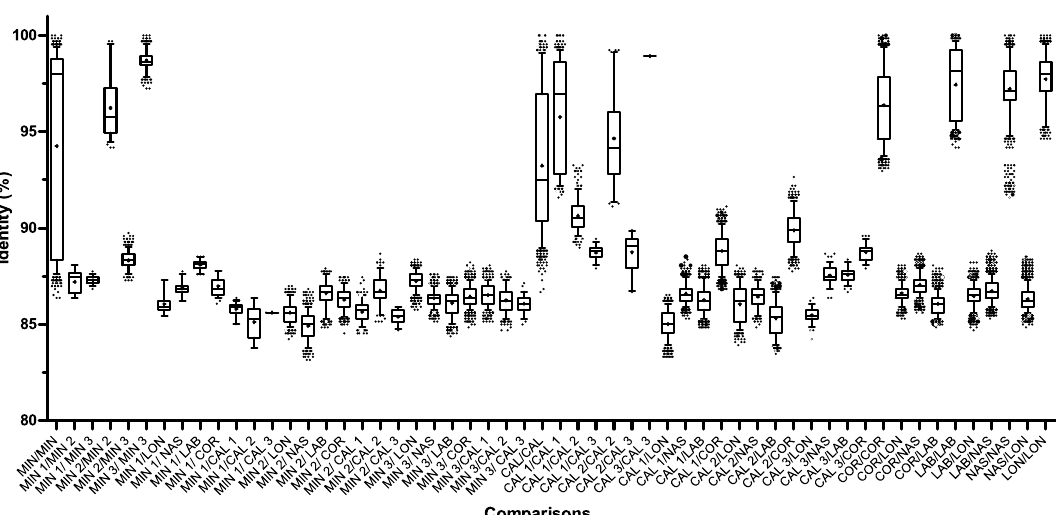
Figure 5. Comparison of sequence identity between different species and operational taxonomical units (OTU) on the cytochrome oxidase I sequences. Identities were calculated using dist.dna function and plotted as boxplots (medians and 25%/75% percentiles) with whiskers showing the 95% percentiles and outliers shown by dots. Means are shown as crosses. Abbreviations on the x-axis indicate the species Coronocyclus coronatus (COR), Cylicocyclus nassatus (NAS), Cylicostephanus longibursatus (LON), Coronocyclus labiatus (LAB), Cylicostephanus calicatus (CAL) and Cylicostephanus minutus (MIN). The OTUs of Cys. calicatus (OTU I, II and III) and Cys. minutus (OTU I, II, III) are represented as CAL 1, CAL 2, CAL 3 and MIN 1, MIN 2 and MIN 3, homogenous species when compared to the other species. Coronocyclus coronatus and Cys. calicatus presented identical sequence clusters to that of the COI tree. Sequence identity analysis. The comparison of sequence identities between and within species and selected OTUs are shown in Fig. 4 for the ITS-2 sequences and in Fig. 5 for the COI sequences. A comparison within all sequences of each species was included. The OTUs from Cys. calicatus and Cys. minutus (from the combined COI and ITS-2 phylogenetic analysis) were considered distinct groups in each analysis and included in the comparison. The “ Cyc. nassatus ” sample identified as Cyc. ashworthi according to sequence data, was